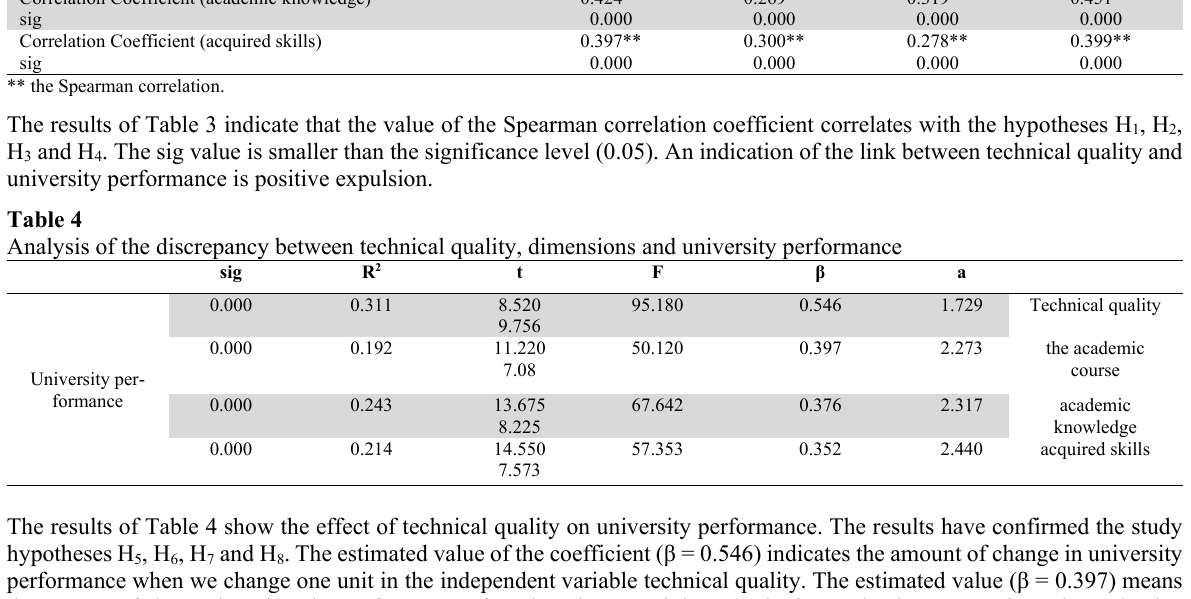
the performance the performance of individuals of the scientific